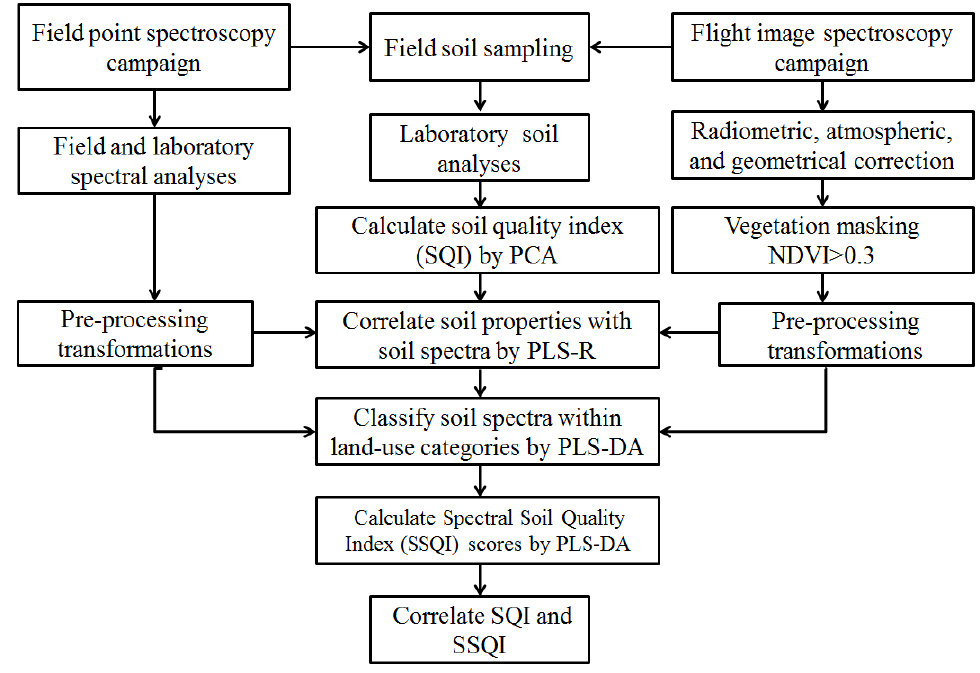
Figure 2. Study flowchart for developing the soil quality index (SQI) and the spectral soil quality index (SSQI) by applying laboratory, point, and image spectroscopy data along with complementary soil measurements and